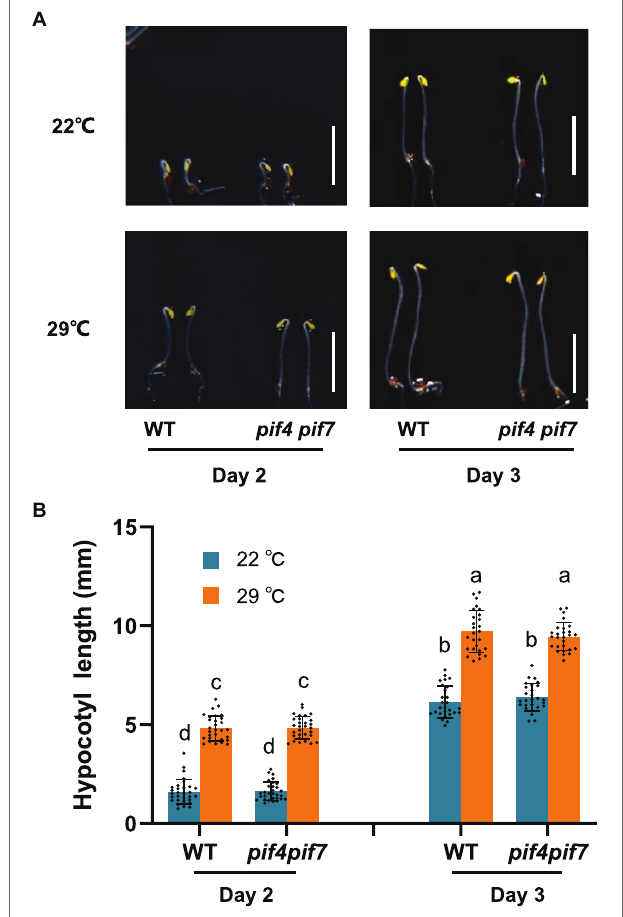
FIGURE 1 | Thermo-responsive hypocotyl growth of Arabidopsis wild-type and pif4 pif7 mutant plants. Wild-type (WT) and pif4 pif7 double mutant plants were grown at 22 ° C or 29 ° C in darkness for the indicated time and photographed (A) , the hypocotyl length of each plant was subsequently measured (B) . The bars depict the SD ( n = 27). Letters above the bars indicate significant differences as determined by HSD test ( p < 0.05). Bar = 5